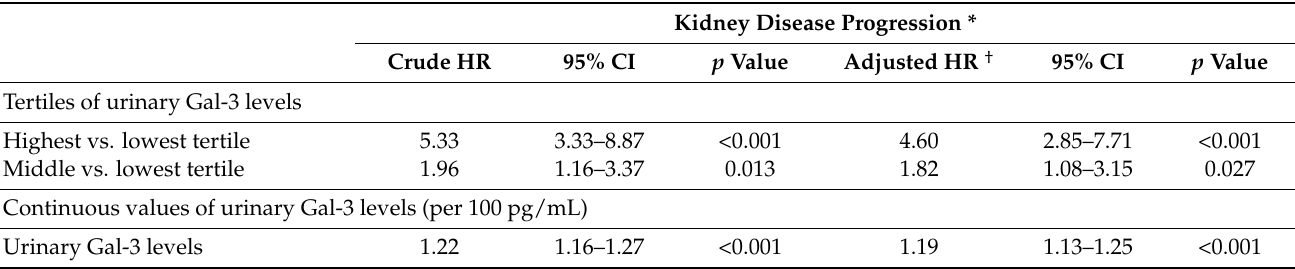
Table 2. Risks of kidney disease progression and urinary Gal-3 levels.